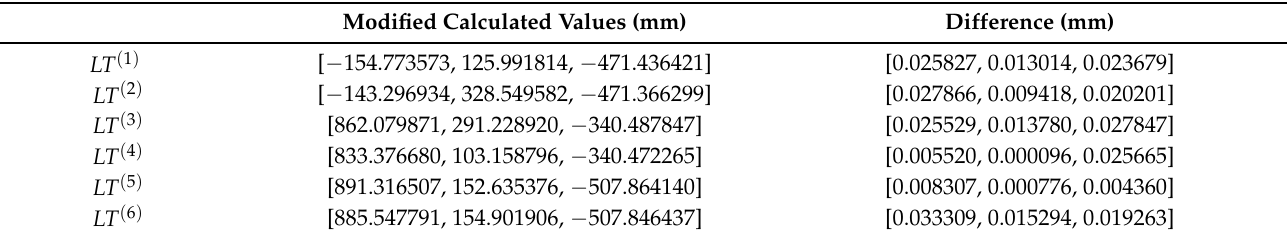
Table 9. Modified calculated LT positions for Case B .